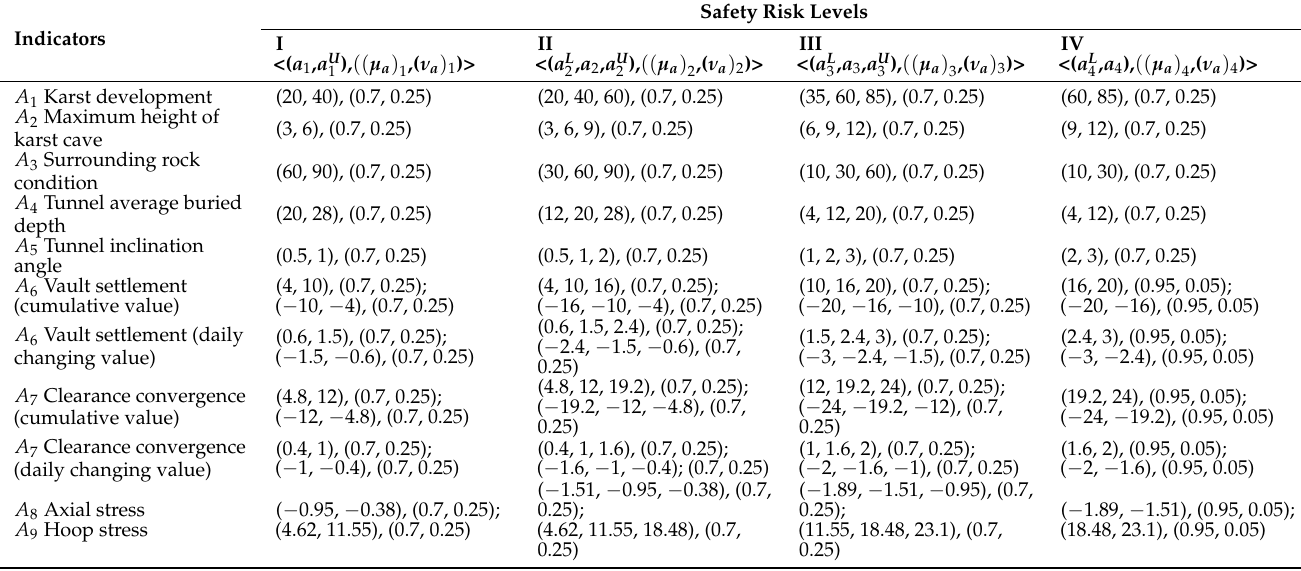
Table 6. IFVs of different indicators under four safety risk